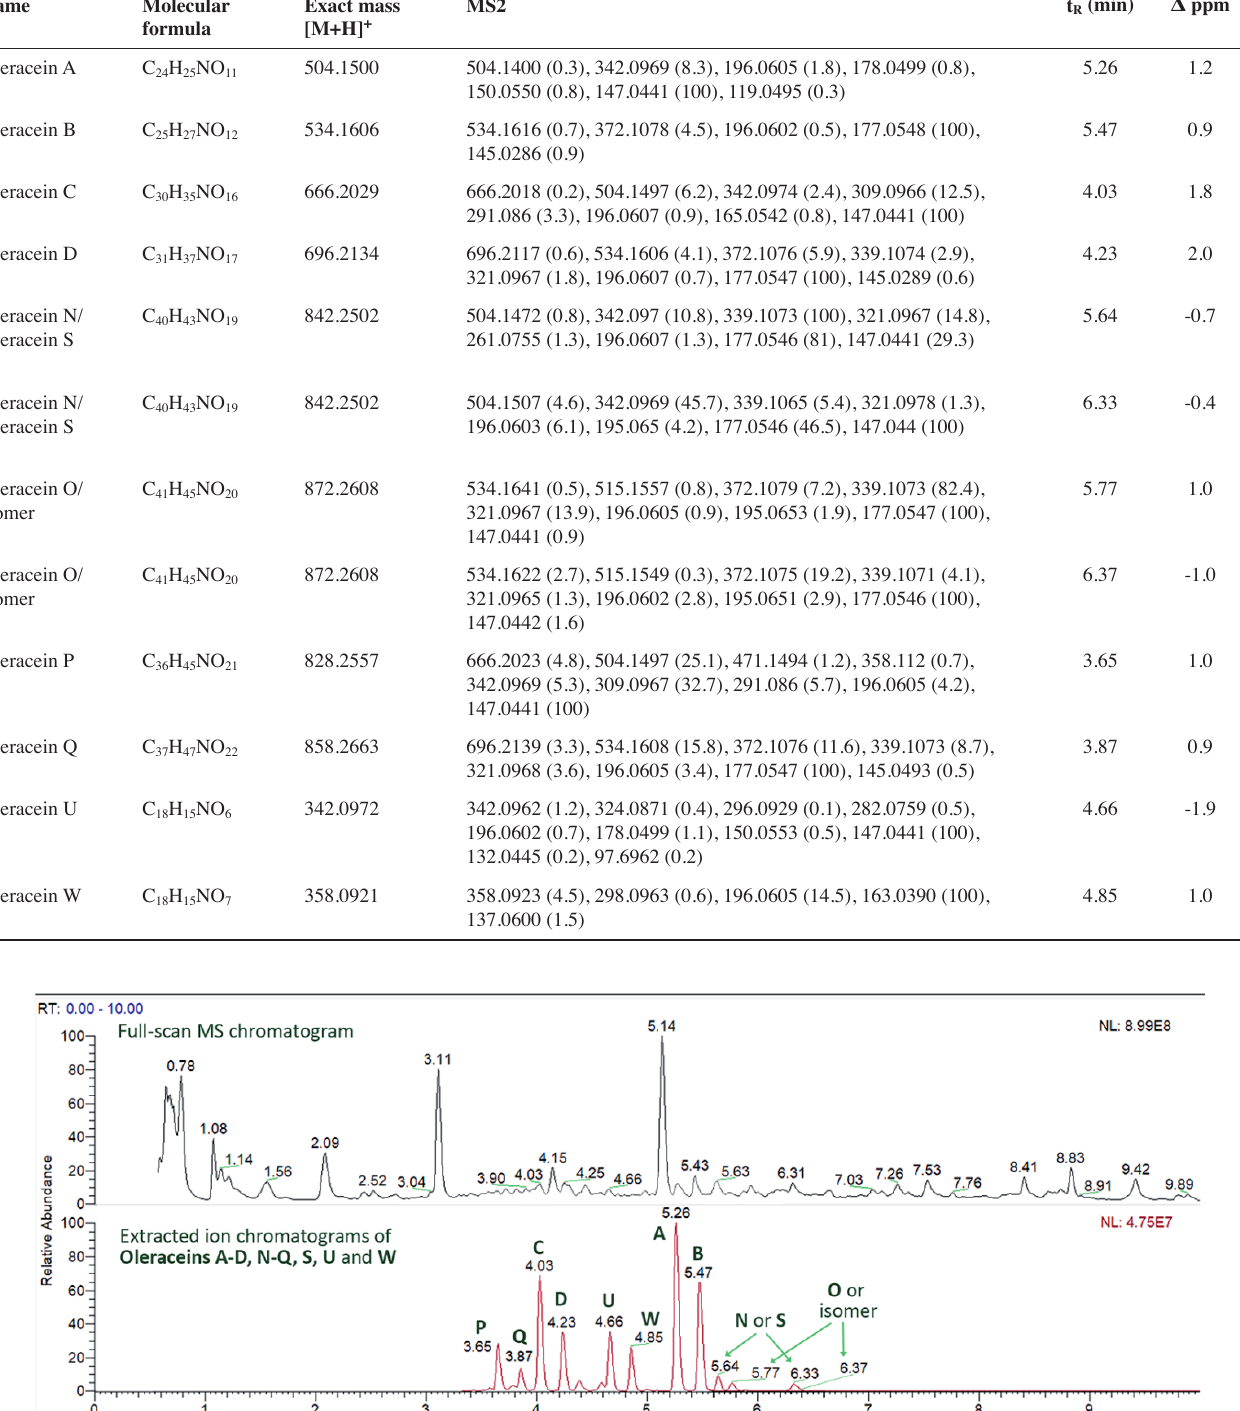
displayed identical and characteristic fragment ions for Oleraceins, however, by the MS 2 analysis it was not possible to state which of the abovementioned two chromatographic peaks corresponds to Oleracein